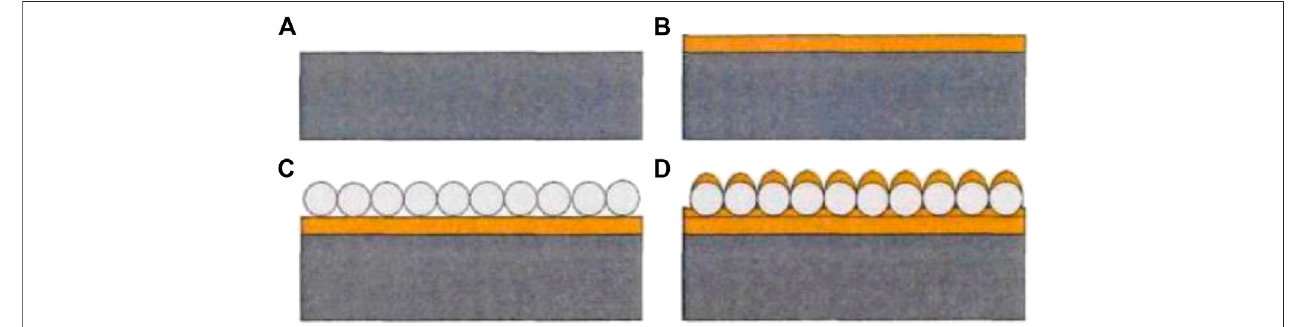
FIGURE 15 | The technological process of fabrication of nano-spherical shell structure. Source : Reproduced from Ref. 35.